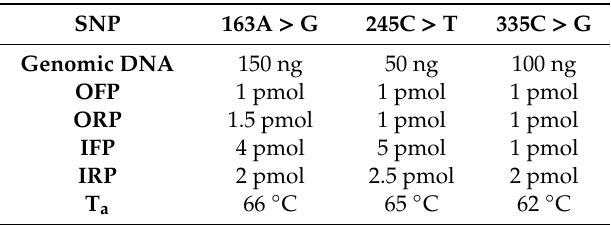
Table 3. Reaction mixture for the SNP characterization with tetra-primer amplification refractory mutation system PCR (ARMS-PCR) contains in 10 µL.